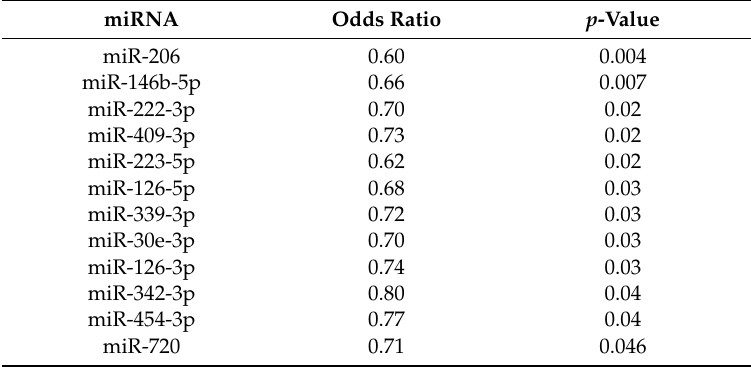
Table 3. Summary of the main findings of the only epigenomic study focused on the association of circulating miRNA with inhaled corticosteroid (ICS) response in childhood asthma